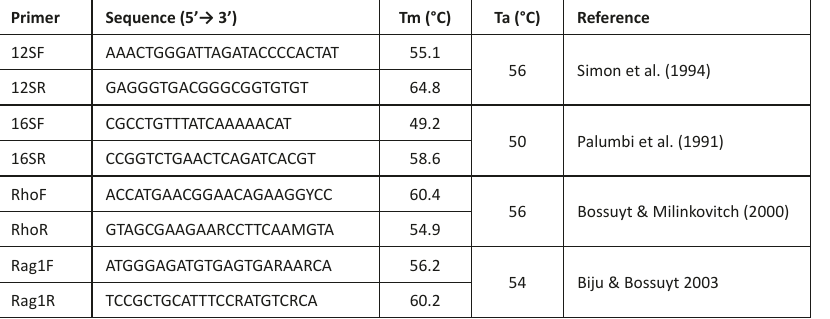
Table 1. Primers used for molecular study along with melting temperature (Tm) and annealing temperatures